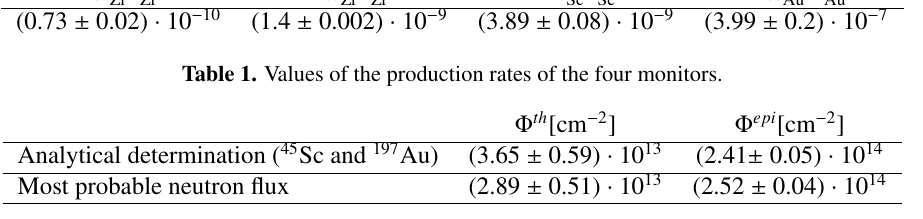
Table 2. Values for the thermal Φ th and the epithermal Φ epi neutron flux component determined analyticaly for the monitor pair 45 Sc and 197 Au and second by using the probability